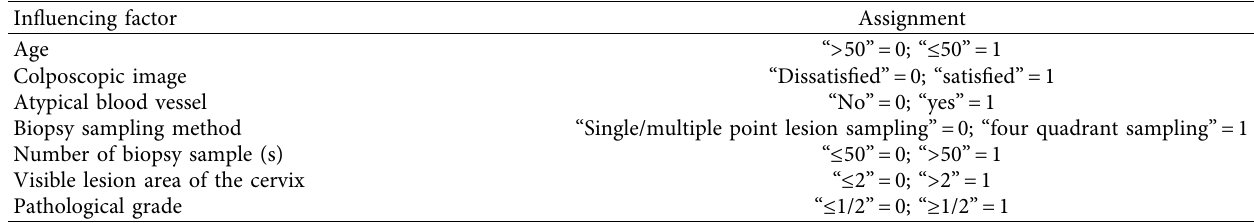
Table 2: Multivariate analysis of the assignment.